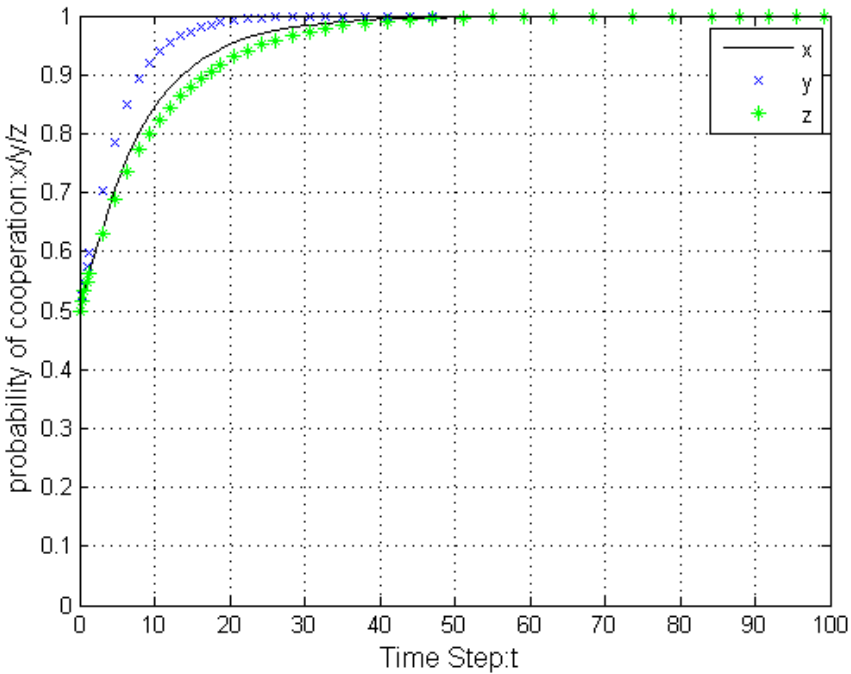
Figure 10. Evolution simulation, Scenario 10.